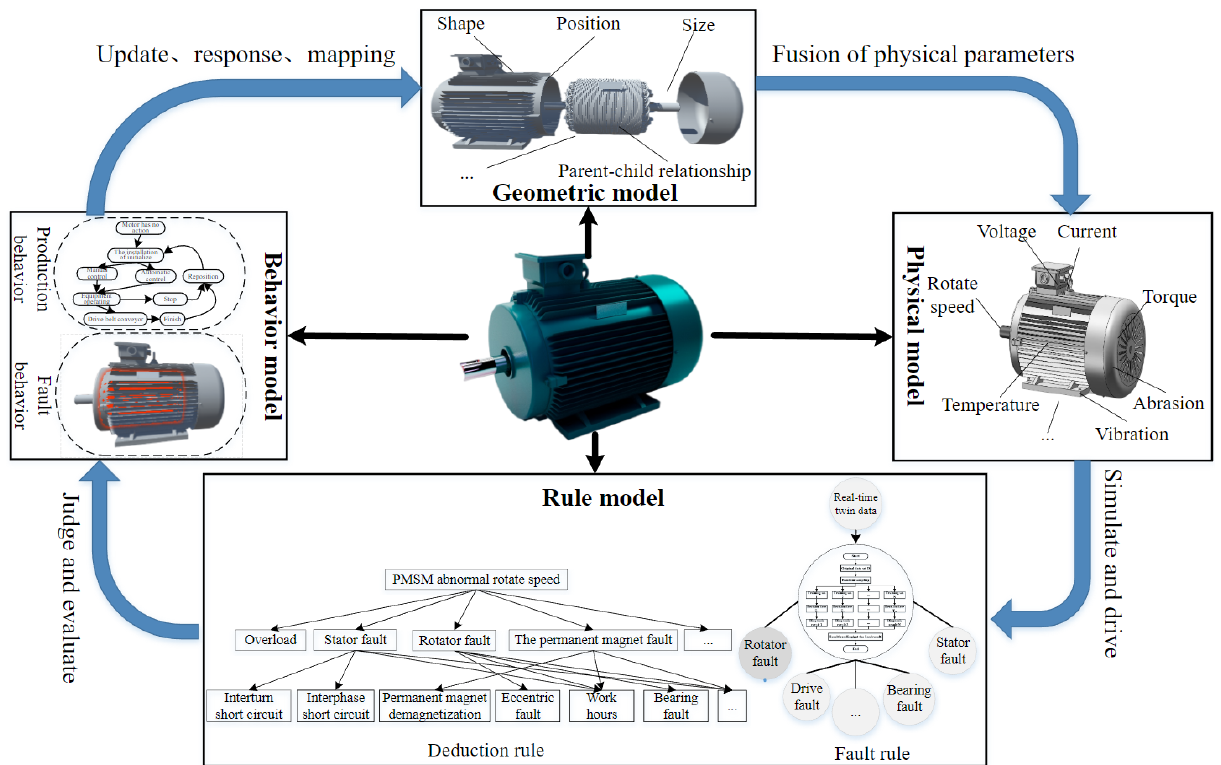
Figure 4. Multidimensional model of